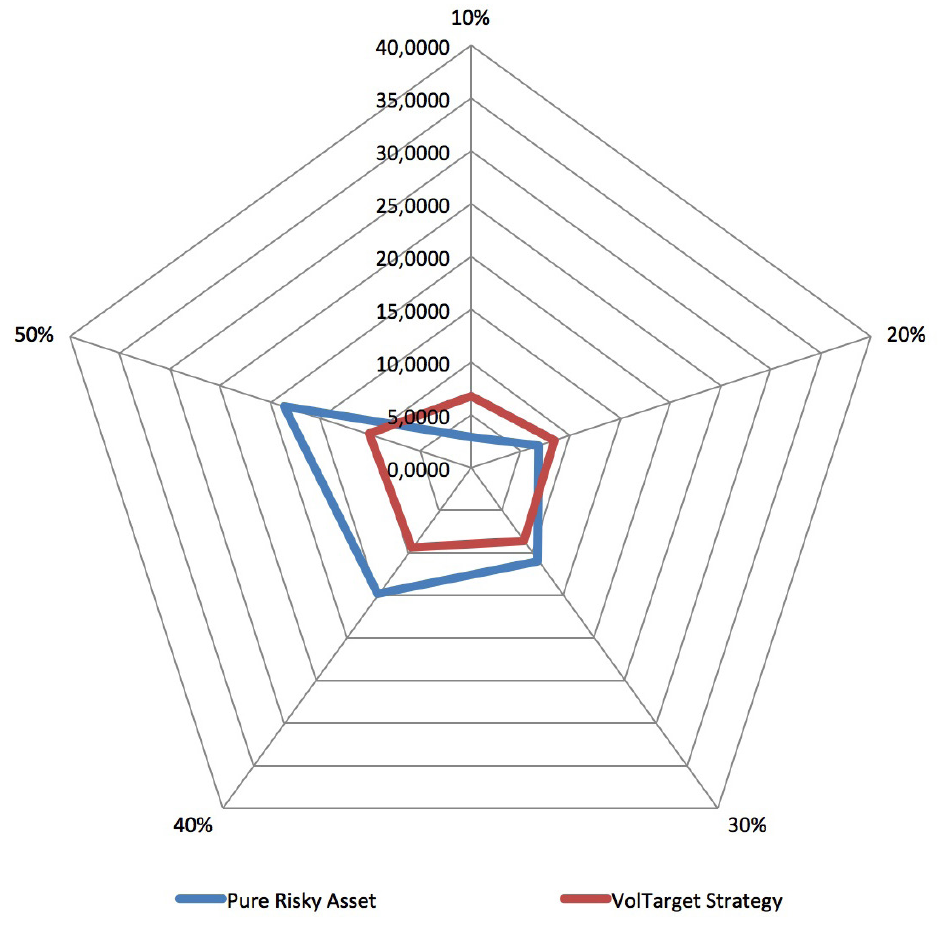
Figure 1. American put option prices with a maturity of one year and a protection level of a Table 4. American floating-strike lookback option prices linked to the pure risky asset Protection level in %/ σ (0)